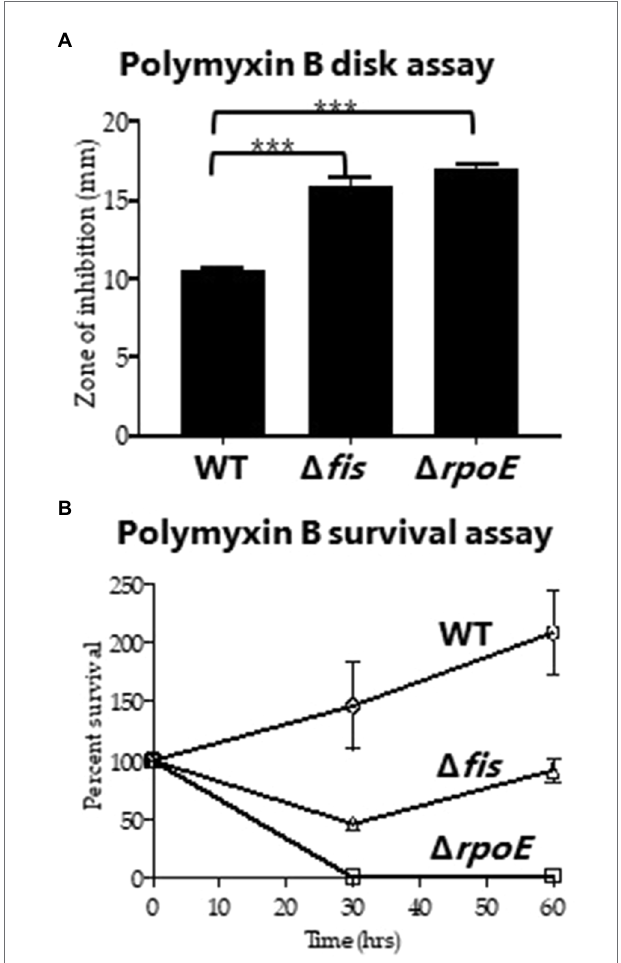
FIGURE 4 | Polymyxin B sensitivity assay. (A) Disk containing 100 μ g of total polymyxin B was used to identify the zone of inhibition for WT, Δ fis and Δ rpoE and was quantified by measuring the diameter of the zone of inhibition. (B) Survival assays were conducted using WT, Δ fis , and Δ rpoE after treating the bacterial cultures with polymyxin B (final concentration of 40 μ g/ml) and calculating percent survival at 30 min and 60 min. The disk assay was performed in duplicate using two biological replicates. The survival assay was performed in triplicate using two biological replicates. Unpaired t -test was conducted to determine the value of p . *** p <